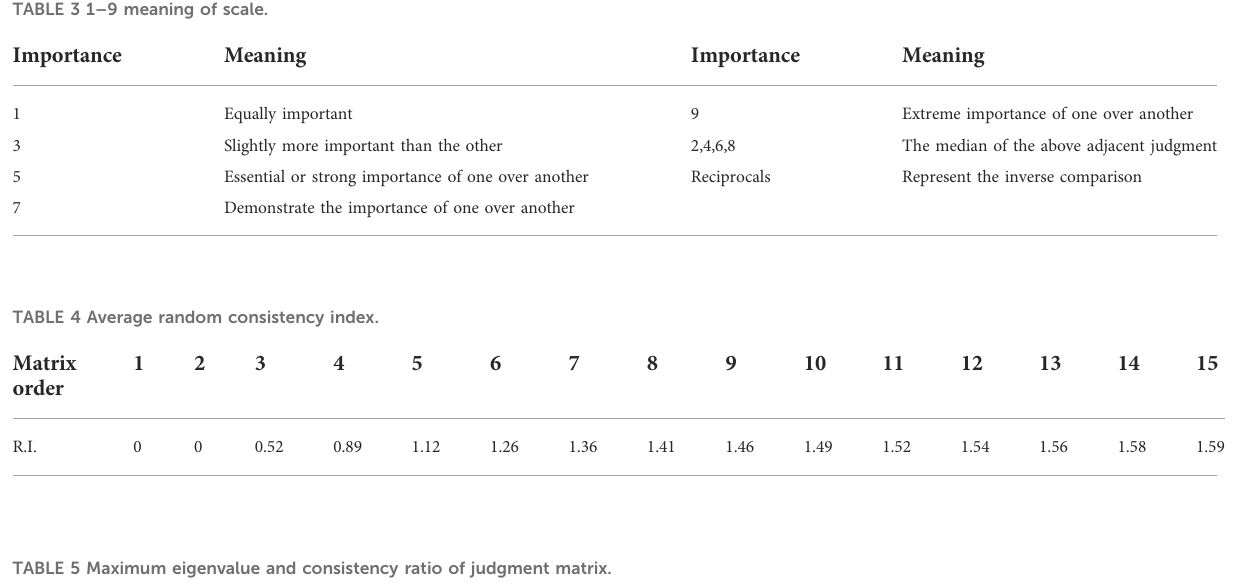
TABLE 5 Maximum eigenvalue and consistency ratio of judgment matrix. Judgment